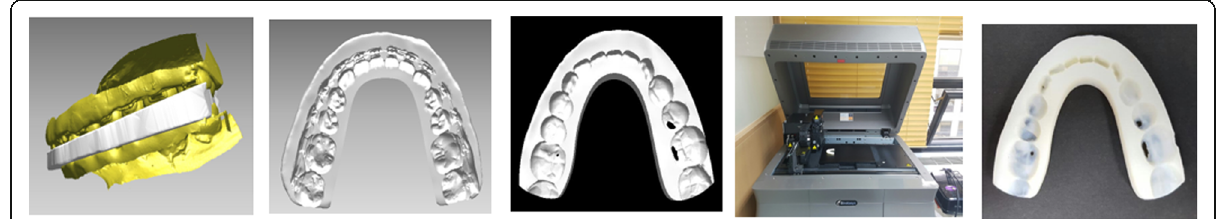
Fig. 3 Stent fabrication progress in virtual surgical